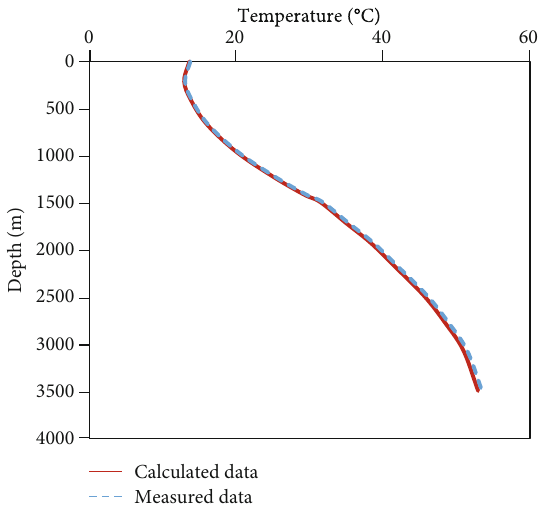
Figure 4: Comparison between the calculated temperature and measured temperature (M-3 well: gasproduction rate = 30 × 10 4 m 3 /d ; waterflow rate = 10m 3 /d